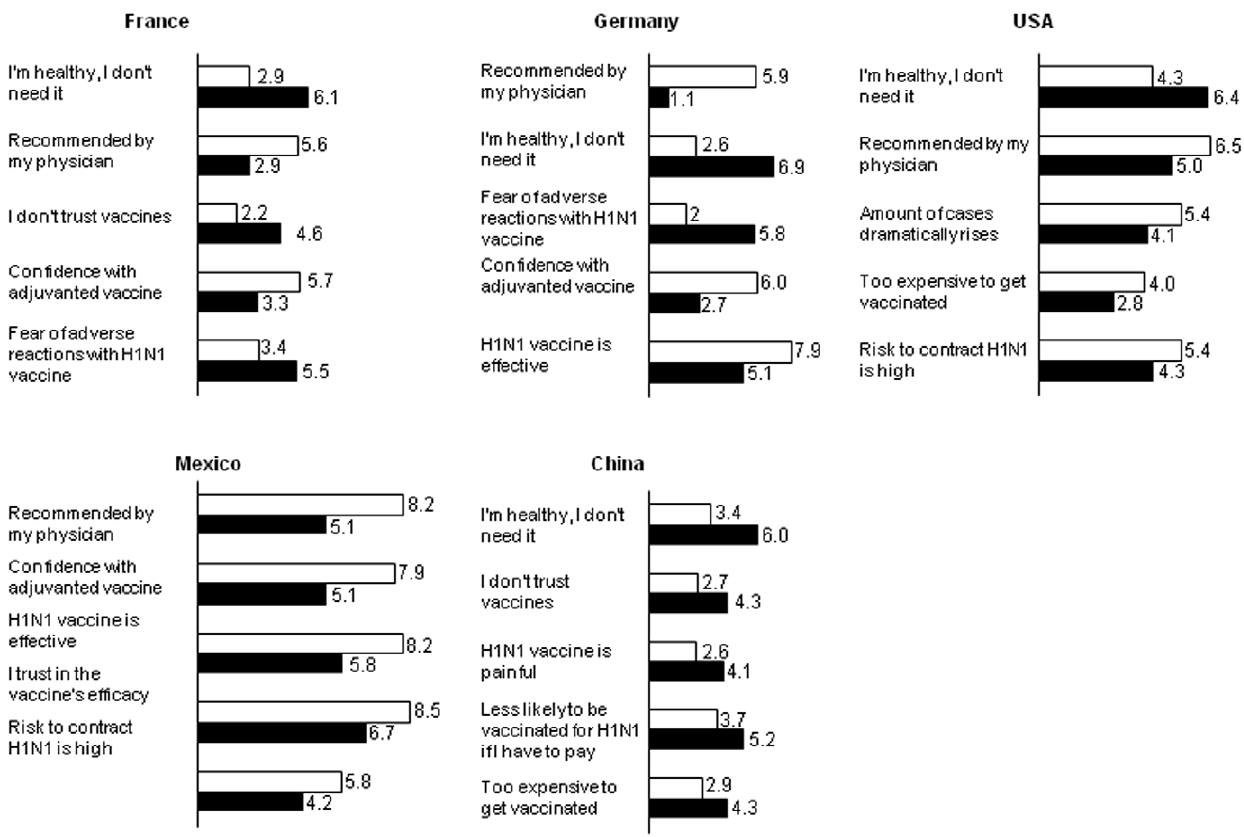
Figure 1. Top five difference in opinions between people vaccinated and unvaccinated for A/H1N1 pandemic influenza. General public respondents (n=500 per country) were asked to score between 0 (totally disagree) to 10 (totally agree) with the following statements: ‘‘In most cases, A/H1N1 flu is a mild disease’’, ‘‘The A/H1N1 flu vaccine works well/is efficacious’’, ‘‘A/H1N1 flu vaccine is not necessary since there are effective medications to treat the A/H1N1 flu’’, ‘‘The A/H1N1 flu vaccination is recommended by my physician’’, ‘‘I am afraid of serious adverse reactions with A/H1N1 flu vaccine’’, ‘‘A/H1N1 flu can send me to hospital’’, ‘‘A/H1N1 flu vaccine is painful’’, ‘‘I do not trust vaccines’’, ‘‘The risk that I contract A/H1N1 flu is high’’, ‘‘The A/H1N1 flu virus is mutating’’, ‘‘The A/H1N1 flu vaccination is recommended by the government’’, ‘‘I am healthy, I don’t need it’’, ‘‘It takes too much time/too complicated to get vaccinated’’, ‘‘It is too expensive to get vaccinated’’, ‘‘The number of A/H1N1 flu cases continues to rise dramatically’’, ‘‘A/H1N1 flu complications are more severe in children than for adults’’, ‘‘I would be much less likely to obtain a A/ H1N1 flu vaccine if I had to pay out of pocket for the vaccine (no insurance/insurance does not cover)’’, ‘‘I am confident with adjuvanted vaccine’’, ‘‘I trust in the efficacy of vaccines’’. Shown are the mean scores for the top five differences between vaccinated and unvaccinated